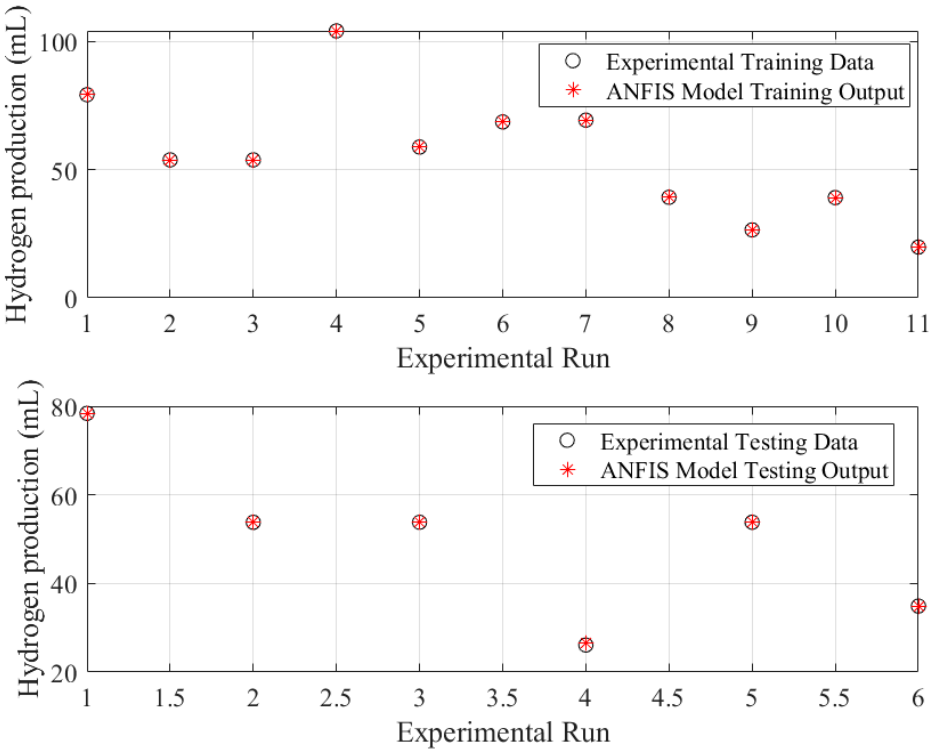
Figure 6. Predicted versus datasets of ANFIS model of water electrocatalysis process.